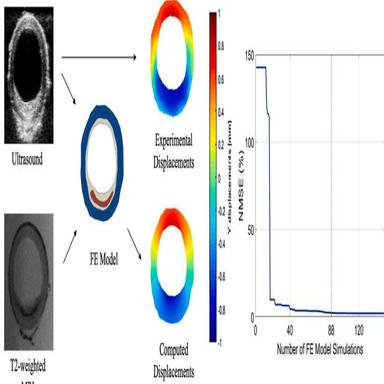
The demonstration of the ultrasound and MR images, FE model, and the experimentally obtained and FE model predicted displacement maps of the representative cross section #8. The minimization scheme reached the optimized solution in 88 function evaluations, following the sharp decrease in the NMSE.